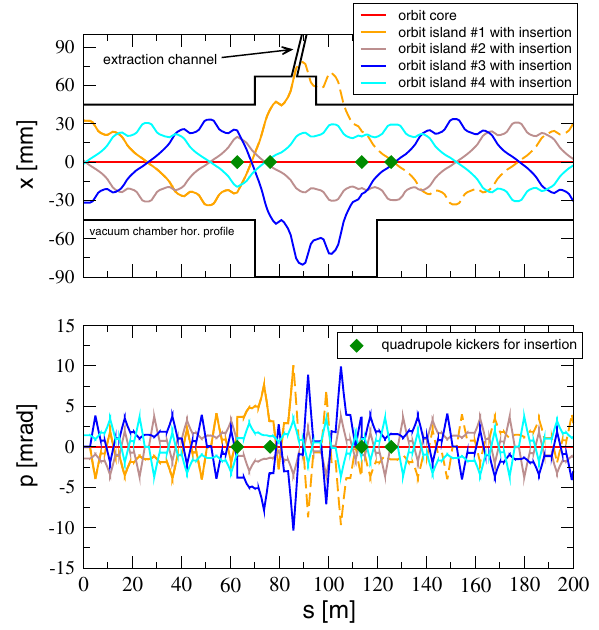
FIG. 4. Modified, septumless, MTE. The distortion of the four islands ’ closed orbits is induced by local insertion optics created by quadrupole kickers, thus leaving the central orbit unaffected. The insertion is optimized so as to have precisely one orbit entering the extraction channel and to ensure that, turn-by-turn, all other islands ’ orbits will exit with the same position and angle. Neither dipole kickers nor septa are used to achieve this result. Only a fraction of the PS circumference is